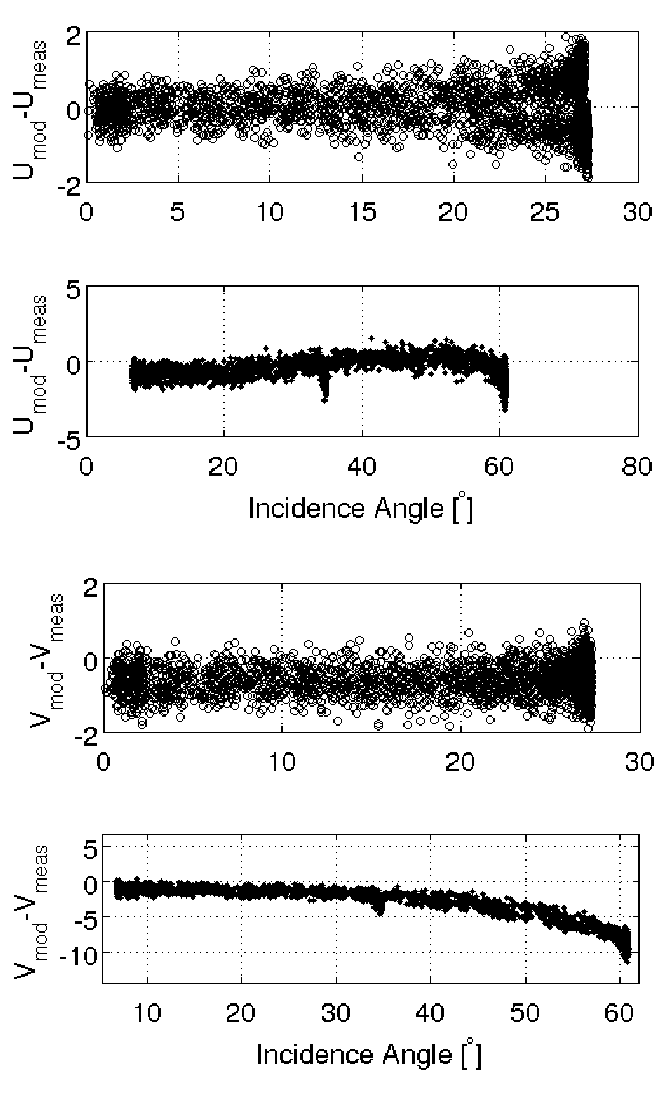
Figure 14. T3 and T4 differences between modeled and measures values (Gulf of Biscay) during the 2009 CAROLS flights, for ±25° wing wags: nadir antenna (upper figures); slant antenna (lower